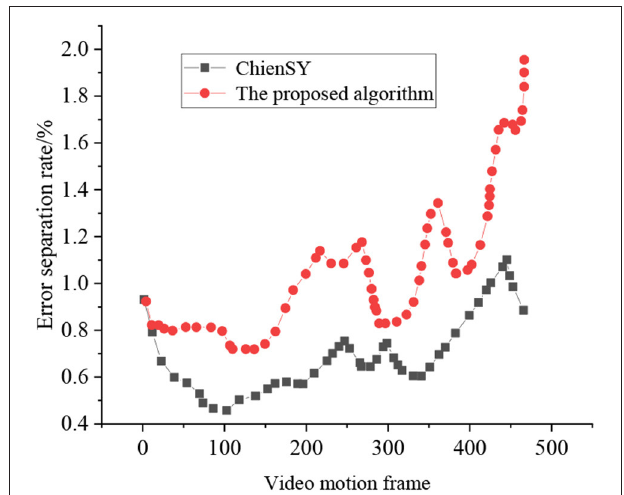
FIGURE 16 | Test results of false separation